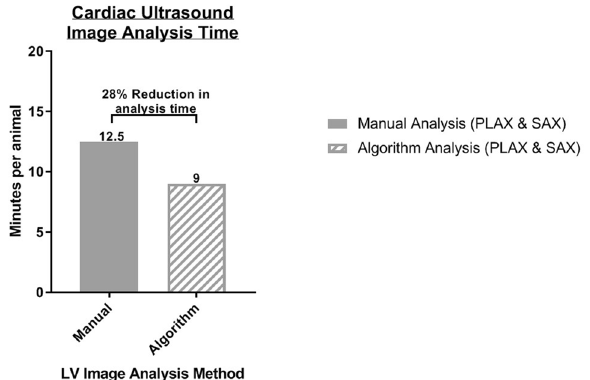
Figure 7. Time of analysis comparison: graphical representation of time required for left ventricle ultrasound image analysis using a manual segmentation method compared to using the semi-automated segmentation algorithm